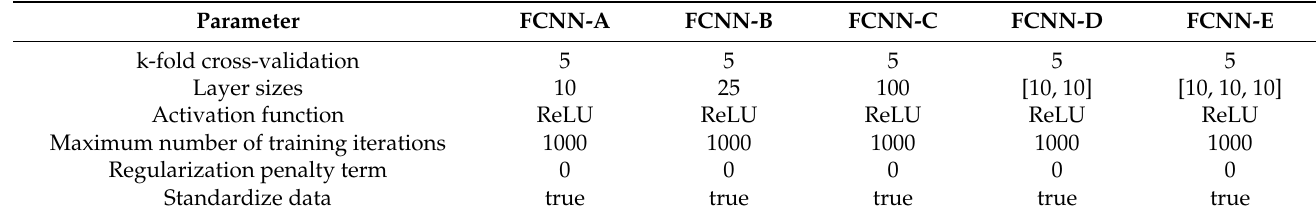
Table 8. Parameter setting of five classifiers.